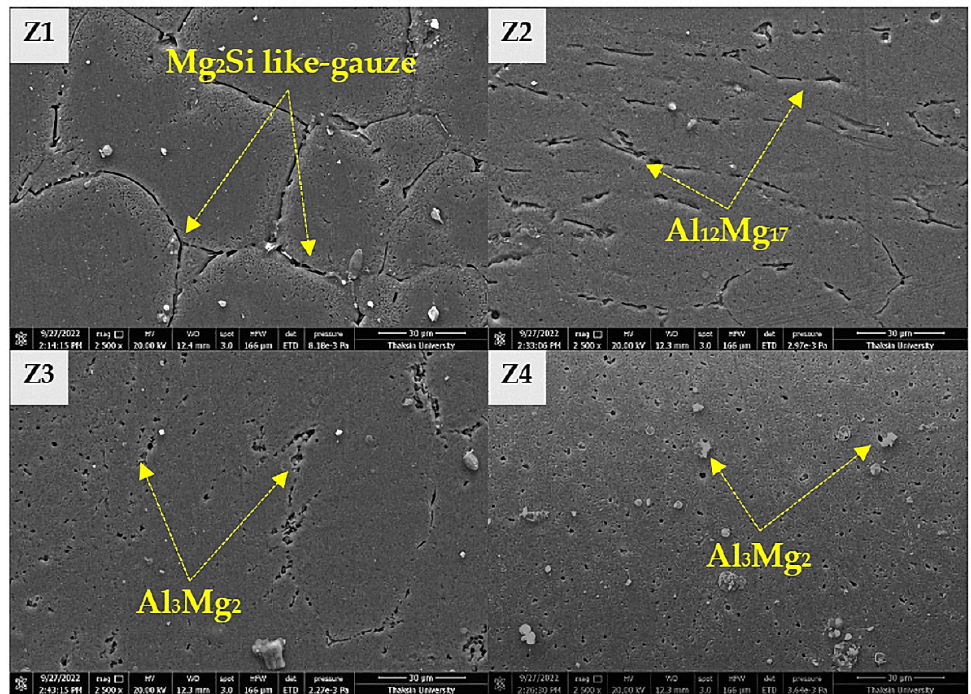
Figure 10. SEM micrographs of different characteristics of Mg 2 Si IMCs taken in EDX mode show the